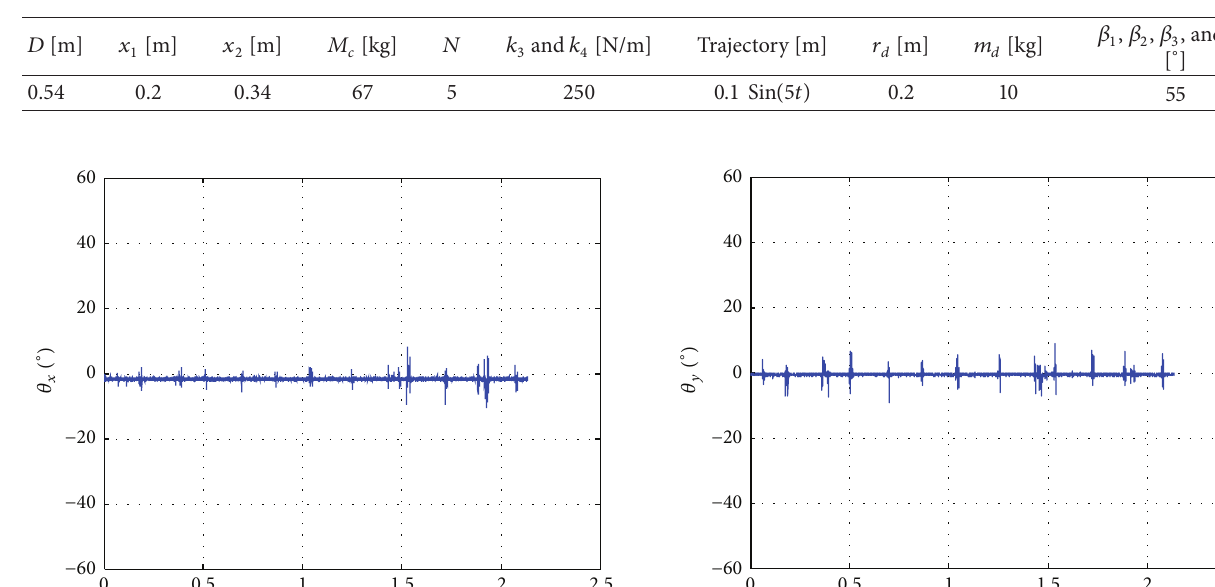
Table 2: Physical parameters.